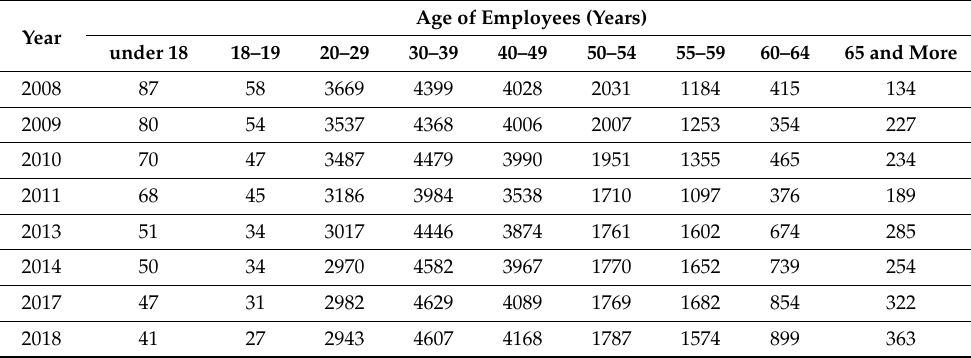
Table 1. Employees in Poland in thousands (own elaboration based on